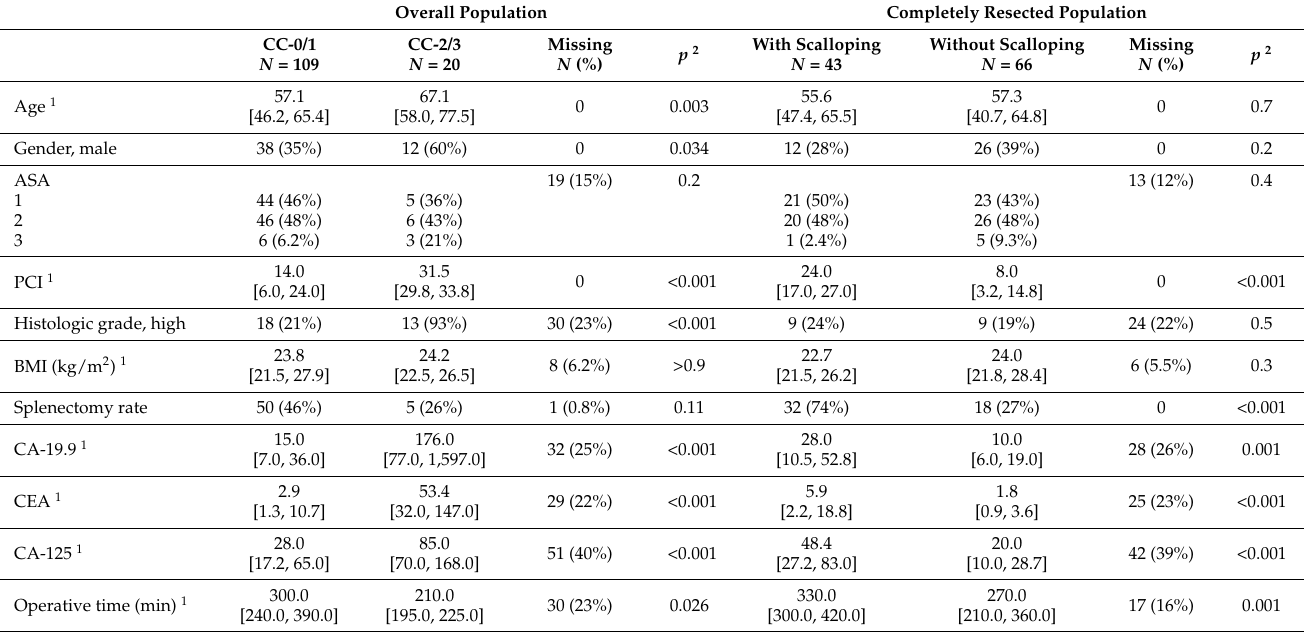
Table 1. Patient Table 1. Patient characteristics.